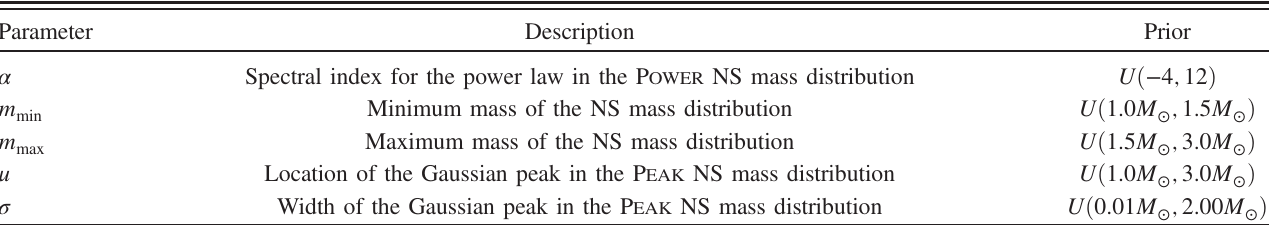
TABLE XI. Summary of P OWER and P EAK NS mass model parameters.